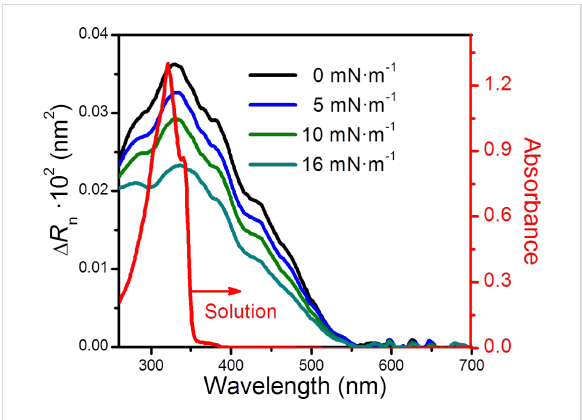
shown. The broad absorption spectra and the red shift of the absorption edge indicate the presence of various two dimen- sional (2D) J-aggregates of 1 on the water surface [92,93]. J-aggregates, named after E. E. Jelley who first discovered them [94], are formed by molecules arranged in an edge-to-edge con- figuration and characterized by an absorption band shifted to a longer wavelength compared to the monomer. Langmuir films of 1 show a decrease in the Δ R n values upon compression, which indicates that there is a gradual decrease of the tilt angle formed by the normal to the surface and the dipole transition moment of the chromophore. This result is in agreement with a progressive reorientation of the molecules in the Langmuir film upon compression.